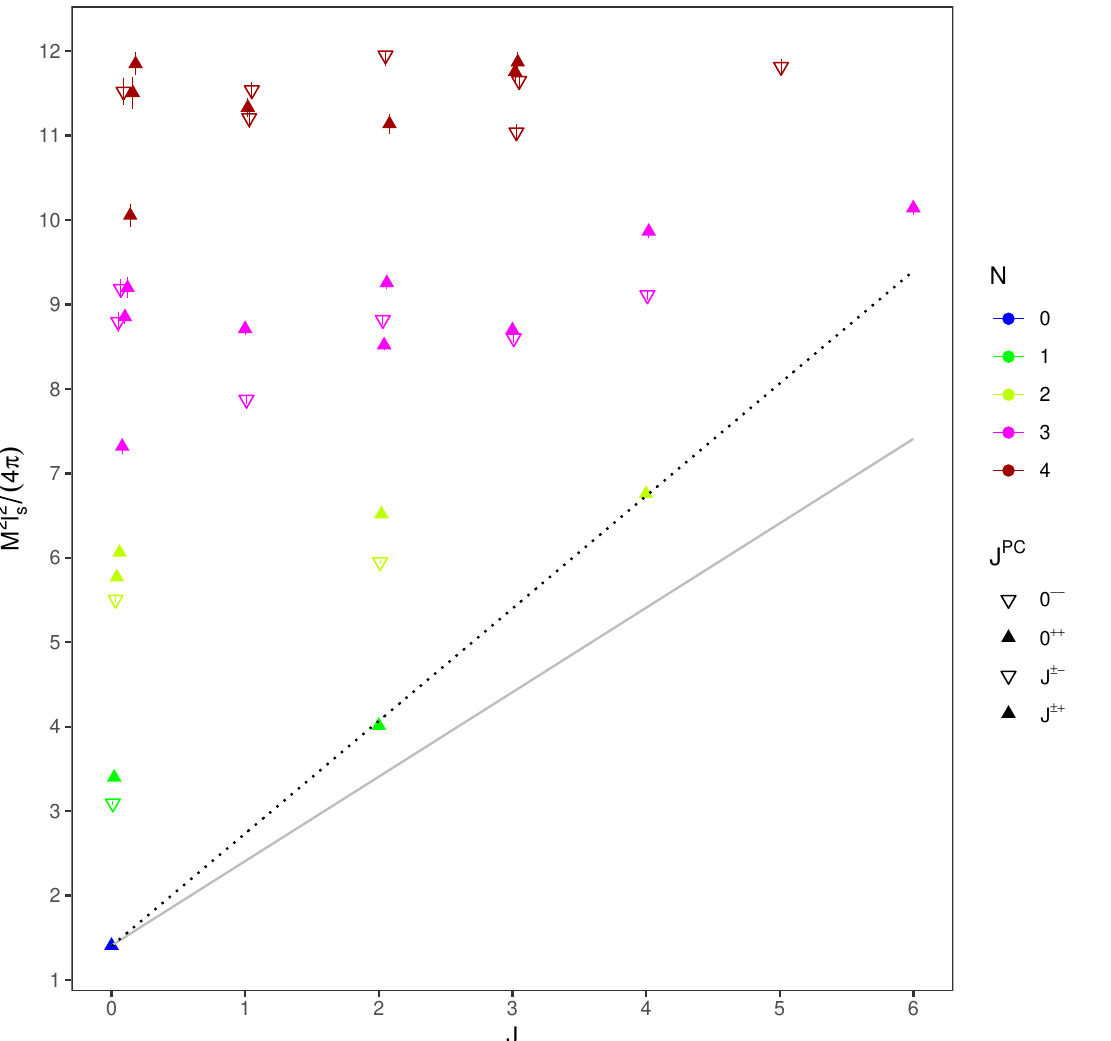
Figure 6. The Chew-Frautschi plot with color coded level assignment up to N = 3. The dotted line is the weighted least squares (cid:12)t to leading Regge trajectory M 2 l 2 light solid line is the linear Regge trajectory with a unit slope line starting at 0 ++ ground